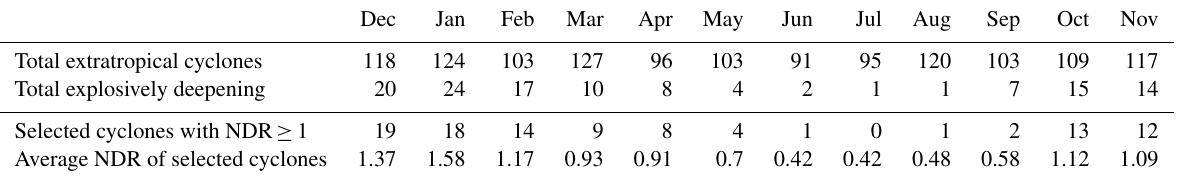
Table 3. Number and intensity of extratropical cyclones in the Northern Hemisphere identified in each simulation period (DEC refers to the 35d simulation initialized on 1 December 2017). The upper part shows the total number of identified extratropical cyclones and how many thereof are explosively deepening. The lower part shows how many of the 24 selected extratropical cyclones are explosively deepening and their average normalized central pressure deepening rate in bergeron.